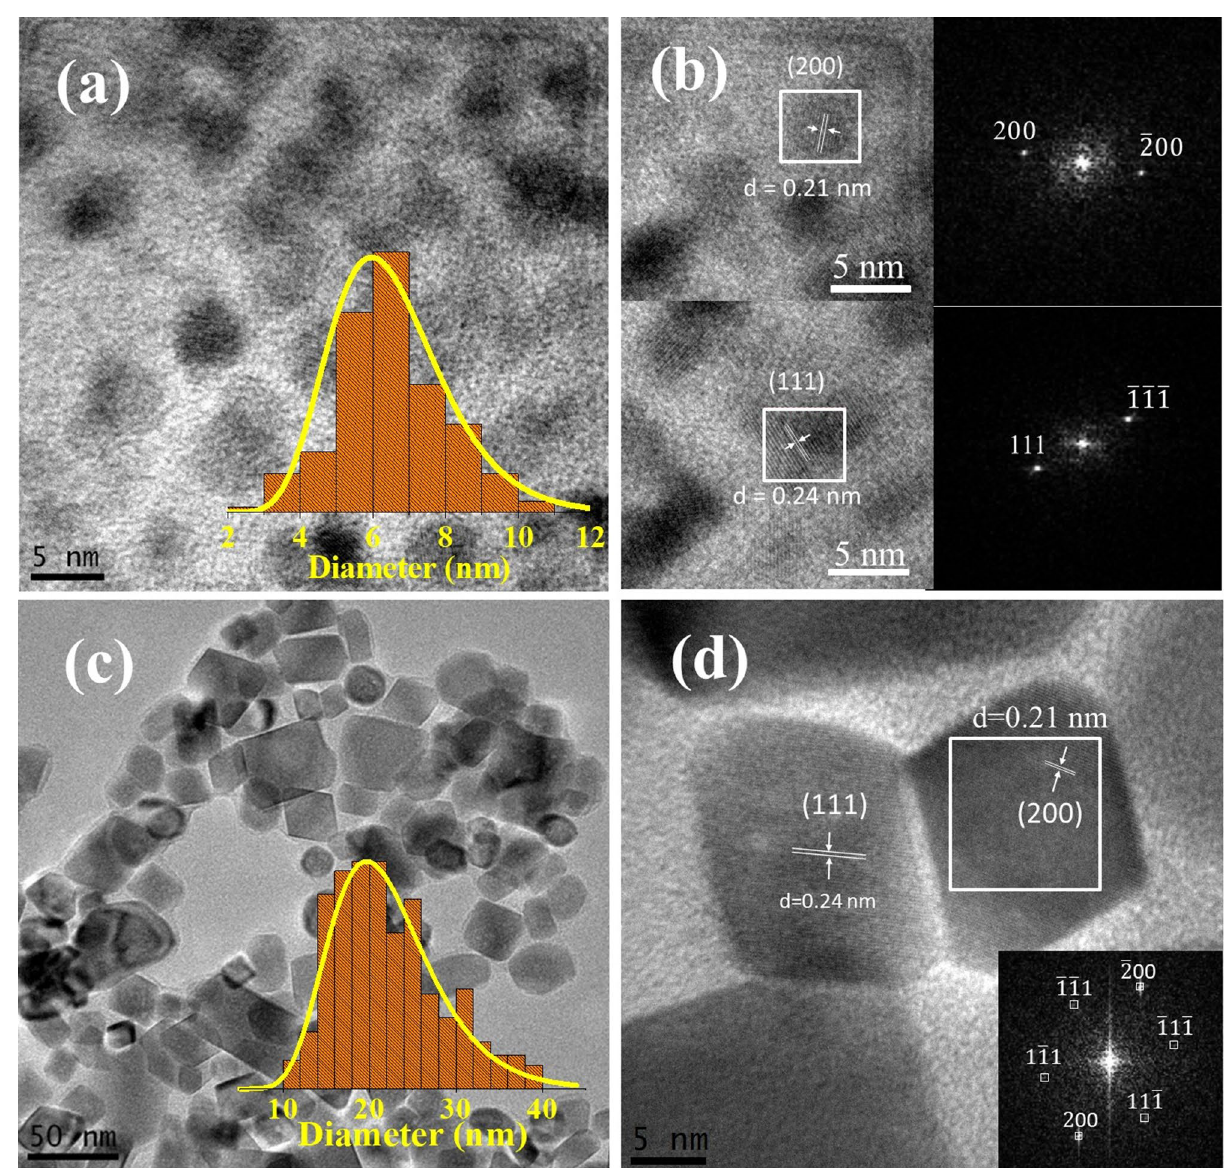
Figure 1. TEM images of CoO samples S1 ( a ) and S2 ( c ). The insets in ( a ) and ( c ) display the log-normal size distribution of particles. High-resolution (HRTEM) images of S1 ( b ) and S2 ( d ) revealing the regular arrangement of lattice fringes. The corresponding fast Fourier transform (FFT) of images are displayed in the insets in ( b ) and ( d ) and show the spacing of 0.24 nm and 0.21 nm at [111] and [200] orientations of CoO phase,